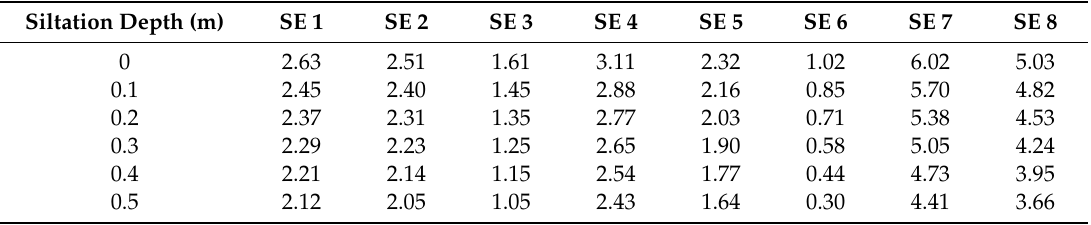
Table 1. E-flow requirements (m 3 / s) for di ff erent river segments (SE) under the high hydrological connectivity scenario with a specified flow velocity of 0.1 m / s.